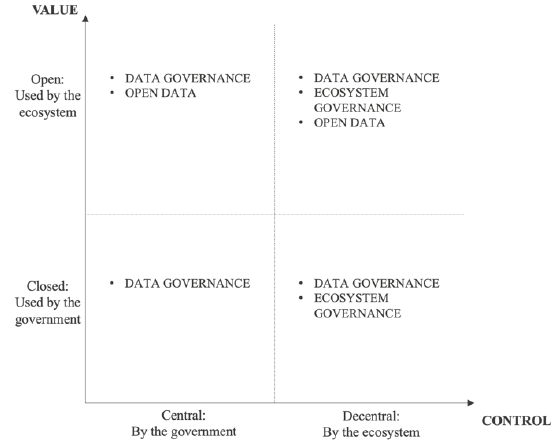
Figure 3. Urban Digital Twin implementation challenges